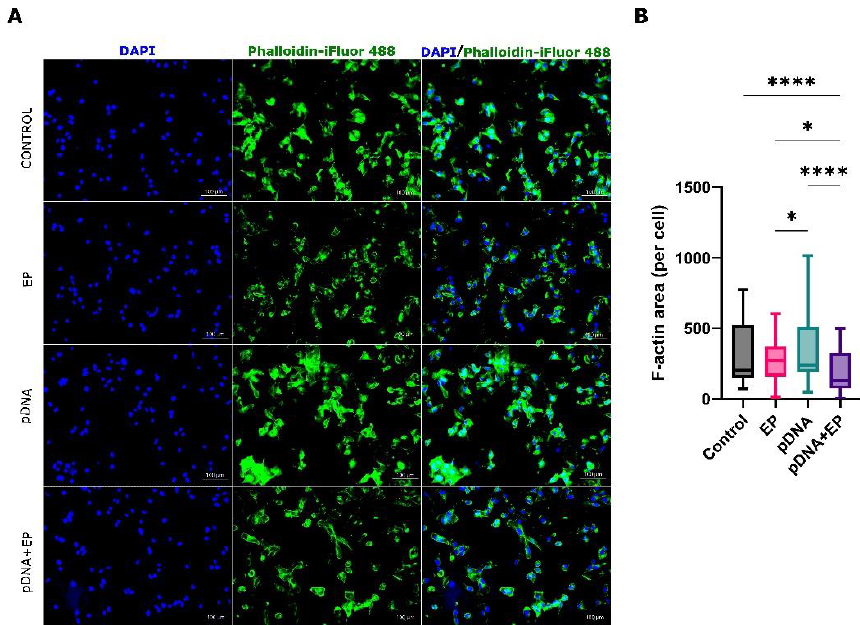
Figure 2. Cytoskeleton staining of B16-F10 cells pulsed in the absence or presence of plasmid DNA. Cells were pulsed in the presence of saline or pDNA (gWizBlank). ( A ) Phalloidin labeled F-actin (green) and DAPI nuclear staining (blue). Scale bar = 100 µm. ( B ) F-actin area per cell. EP, electroporation. n = 3 per group. **** p < 0.0001; * p < 0.05.